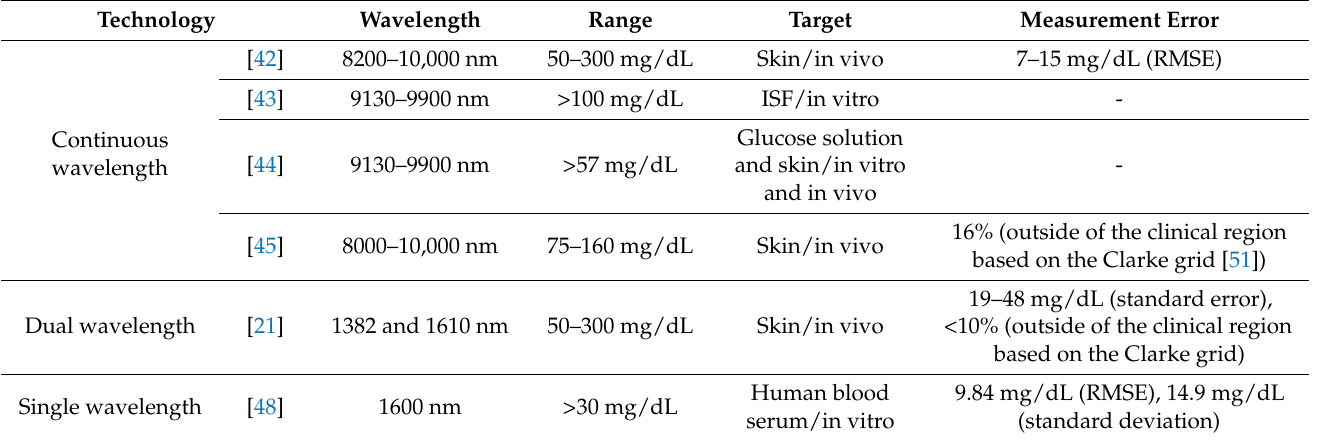
Table 1. Comparison of different PAS